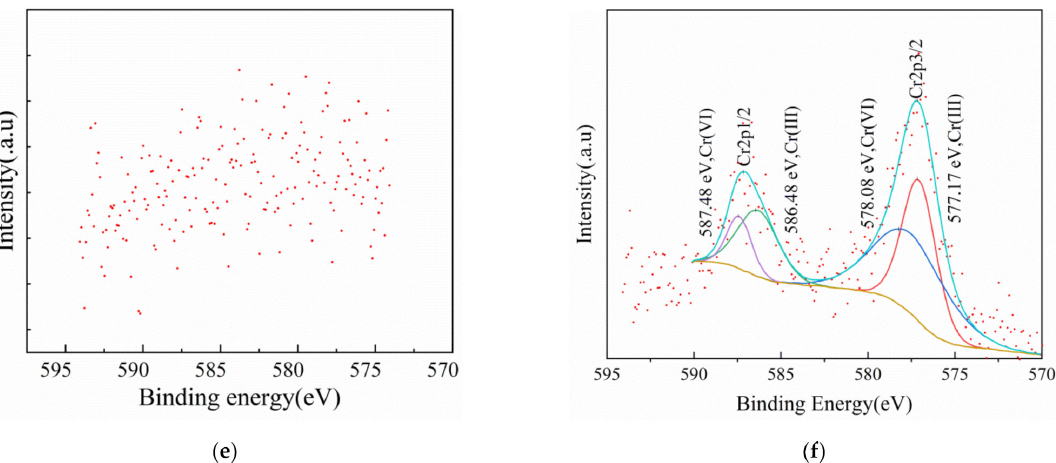
Figure 11. High resolution spectra of ( a , b ) O1s before and after reaction; ( c , d ) N1s before and after reaction; ( e , f ) Cr 2p before and after reaction.